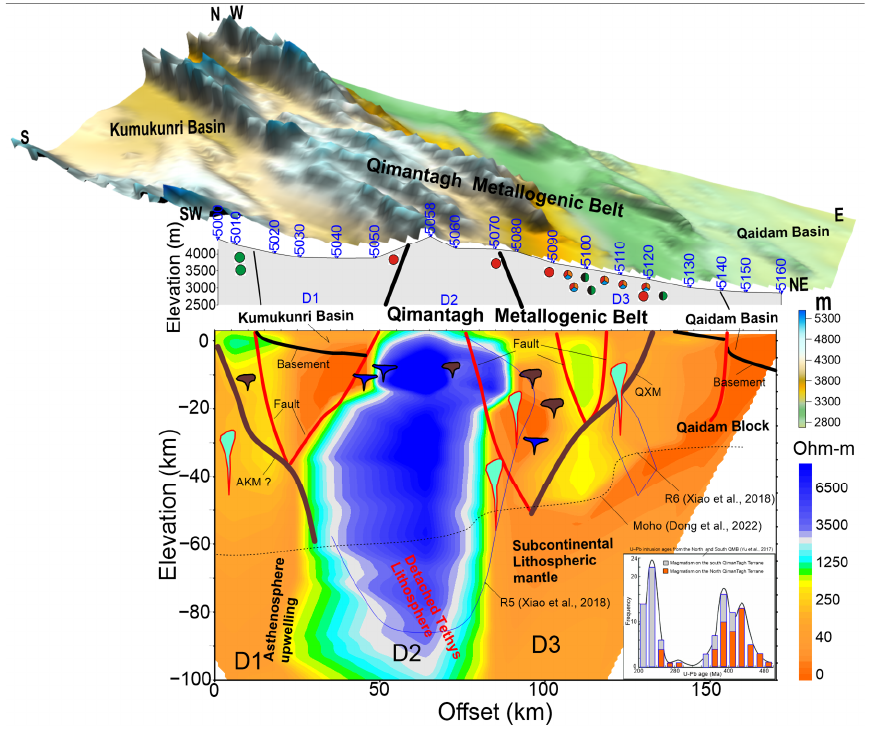
Figure 6. Comprehensive tectonic and geophysical model for understanding the distribution of mineral deposits and the crustal electrical structure of QMB. The geological interpretation is referenced from [10,11,33,34]. References cited in the figure: